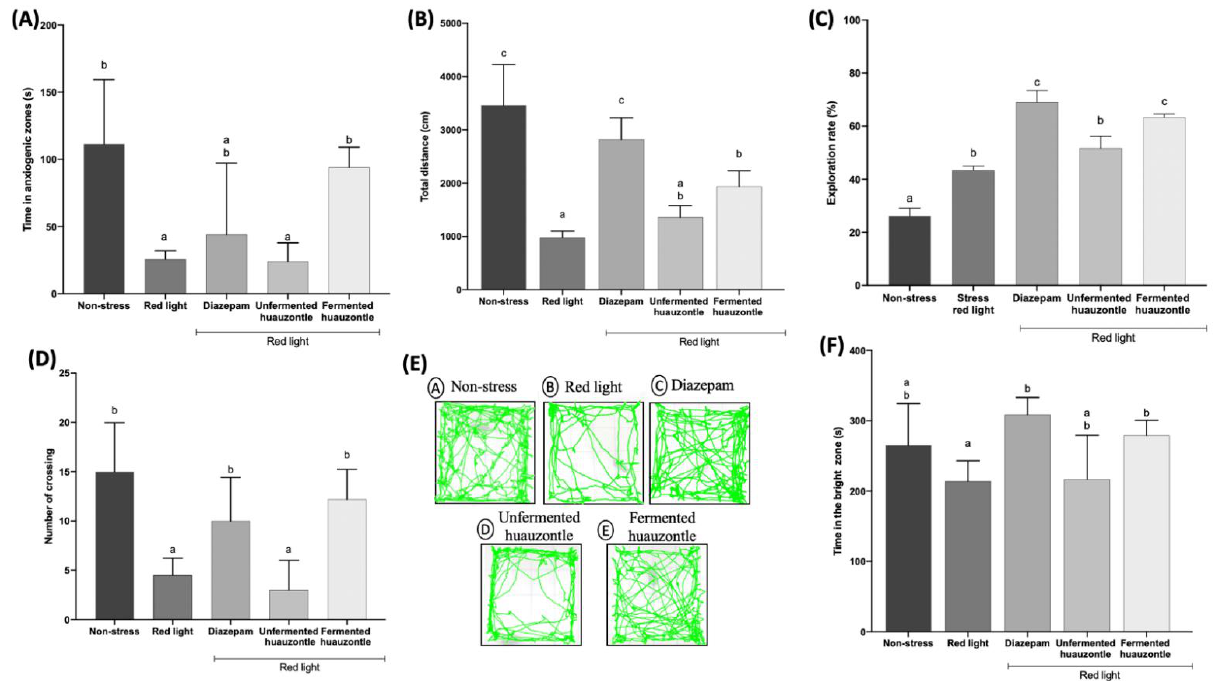
Figure 2. Effect of huauzontle on anxiety-related behaviour in the Elevated Plus Maze (EPM), Open Field Test (OFT) and Dark/light Transition Test (LDT). ( A ) Time in anxiogenic zones for EPM test; ( B ) Total distance travelled; ( C ) exploration rate; ( D ) number of crossings; ( E ) Representative imagen of OFT test. ( F ) Time in the bright zone for dark/light zone. Different letters indicate statistical difference among groups, EPM data analysed by Kruskal-Wallis and the date are expressed as median and IC90 for EPM. OFT ( B – D ) and dark/light analysed by parametric statistics (one-way ANOVA) with p < 0.05. Data are expressed as mean ± SEM (n = 5) .